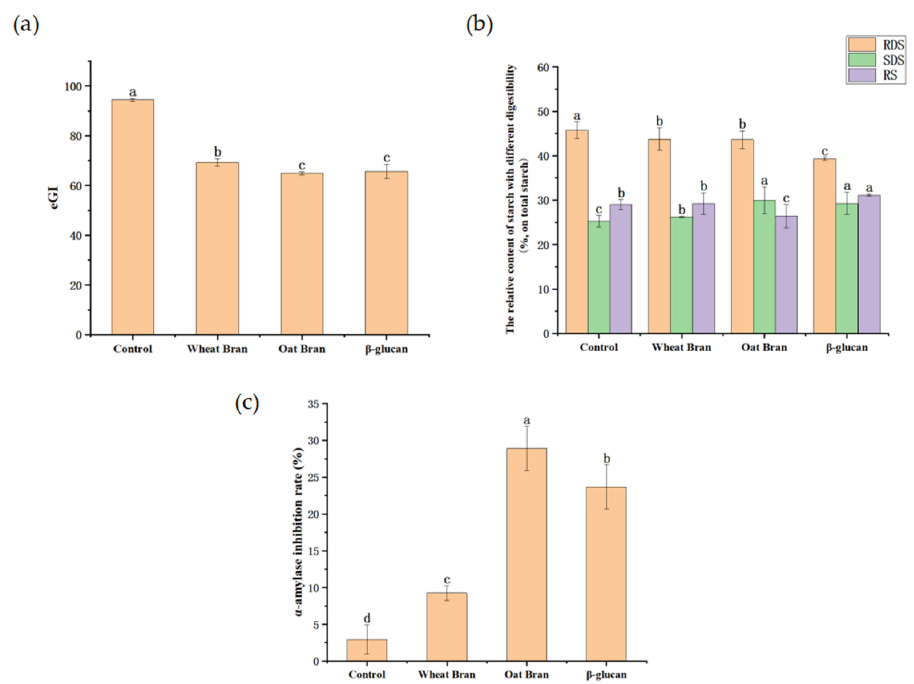
Figure 2. ( a ) Effects of different additives on the estimated glycemic index (eGI) of bread; ( b ) effects of different additives on the relative content of starch with different digestibility in the breads; ( c ) effects of different bread water extracts on the inhibition rate of α -amylase. Note: Different lowercase letters among the data in the same index in each subfigure indicate significant differences ( p < 0.05).